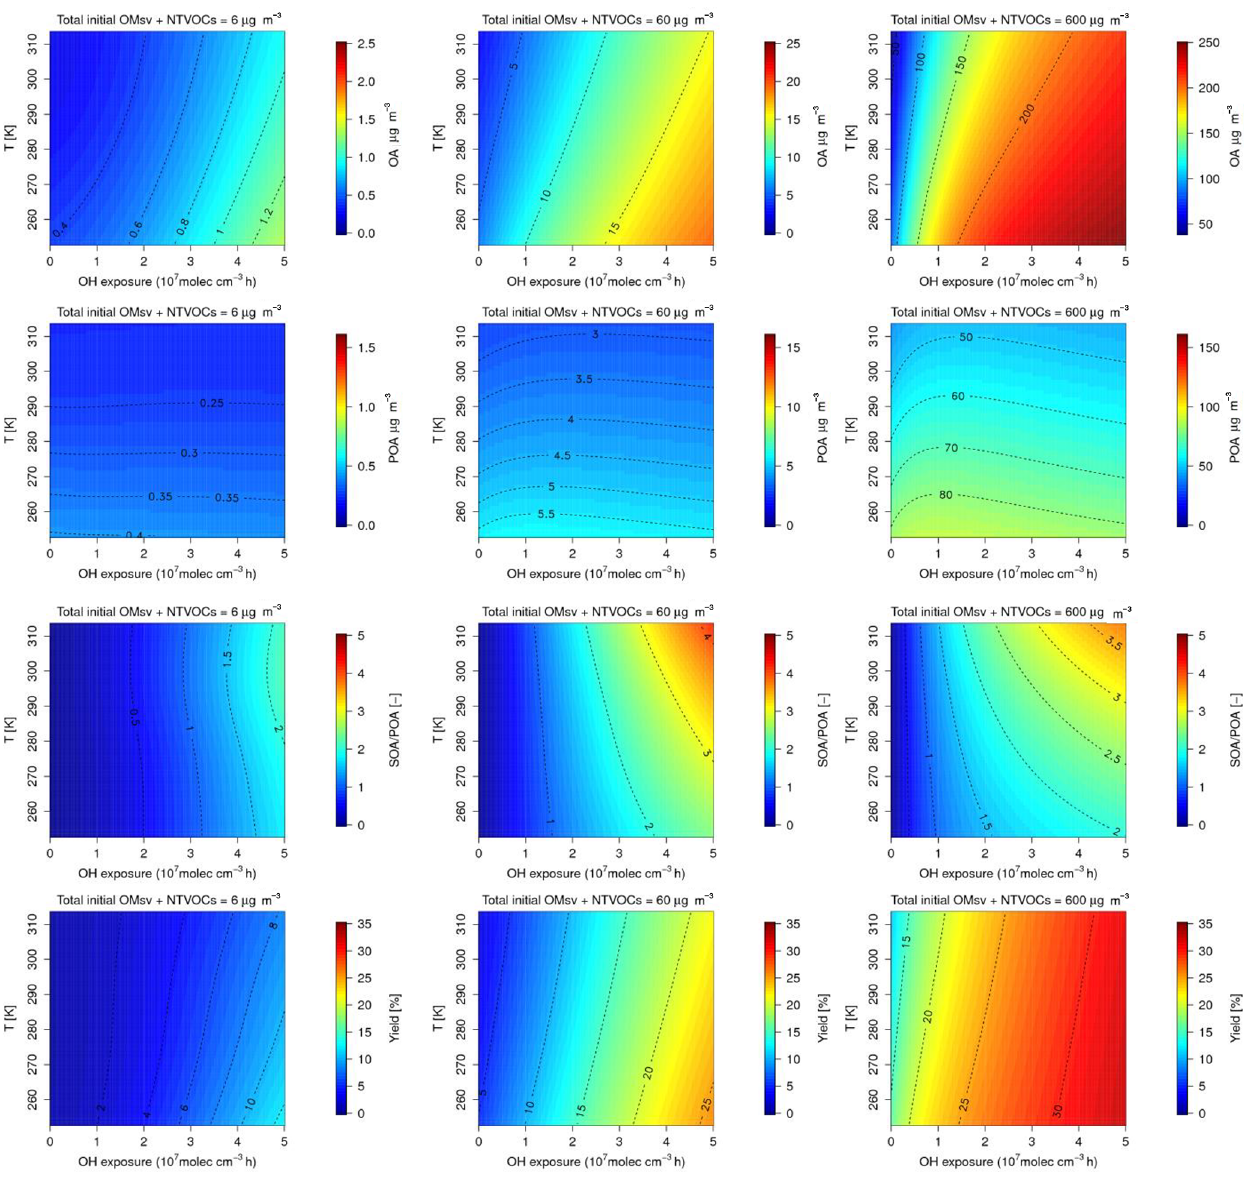
Figure 6. Predicted OA mass (upper panels, note different scales), POA mass, SOA / POA ratio (middle panels) and yields (lower panels) at different OMsv + NTVOCs initial load and atmospheric conditions ( T